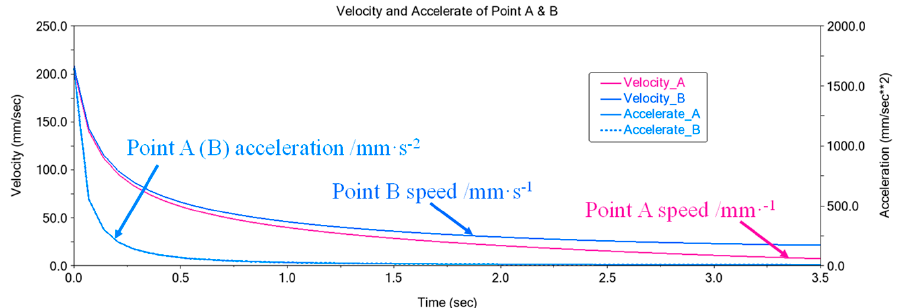
Figure 14. Trajectory diagram simulated by ADAMS.